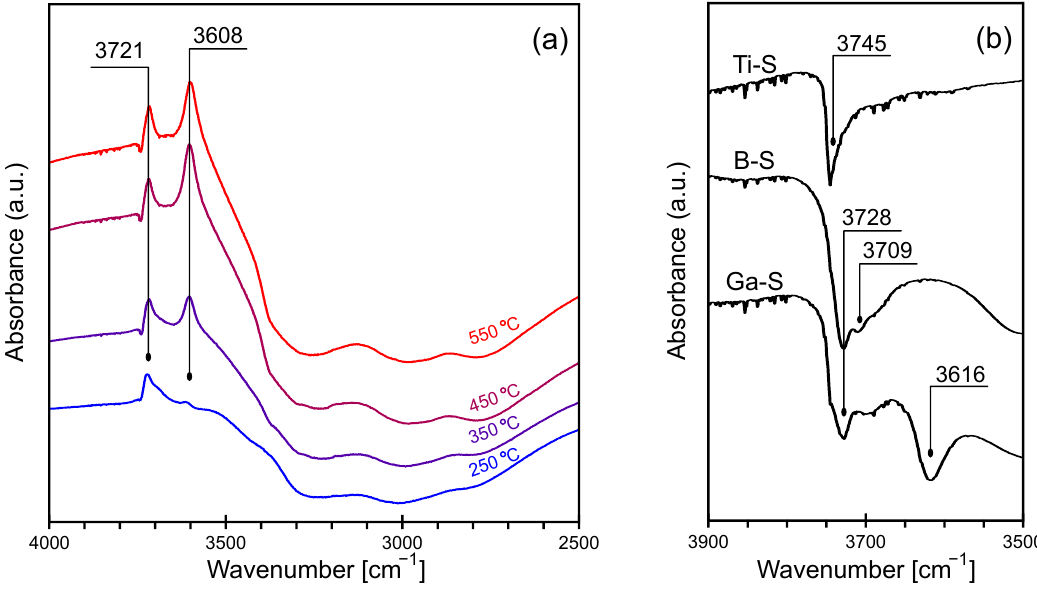
Figure 3. ( a ) Background subtracted IR spectra of the Ga-silicalite sample in the NH + 10% O 2 /Ar. The background was taken at 200 ◦ C in 10% O 2 /Ar; ( b ) IR spectra recorded at room temperature in Ar of the B-, Ga- and Ti- silicalite samples in the H +